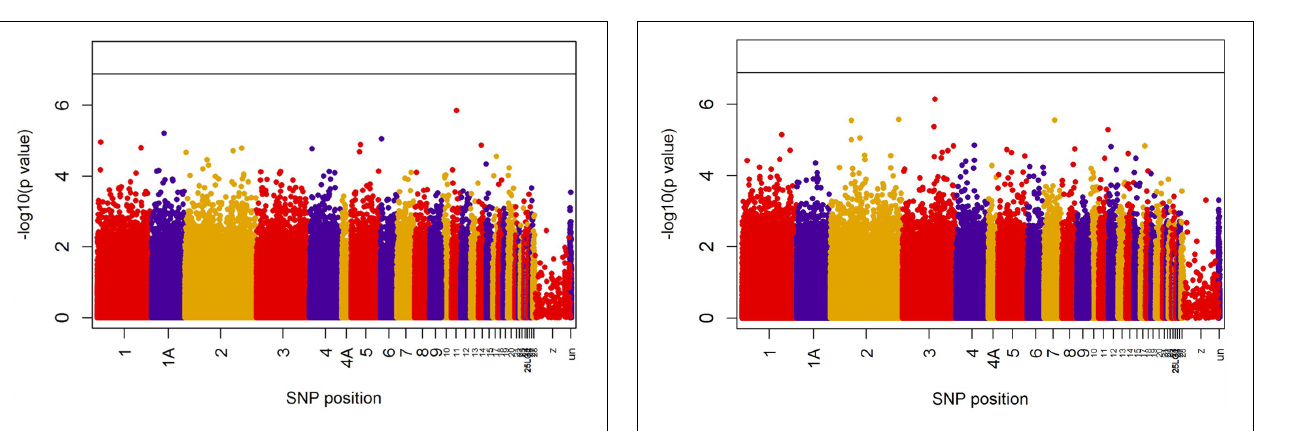
TABLE 2 | The 10 most significant SNPs for genome-wide association analyses testing for an interaction between SNP effects and temperature, ordered by significance. SNP Chr Genome pos. p -value MAF Ref. allele Gene symbol